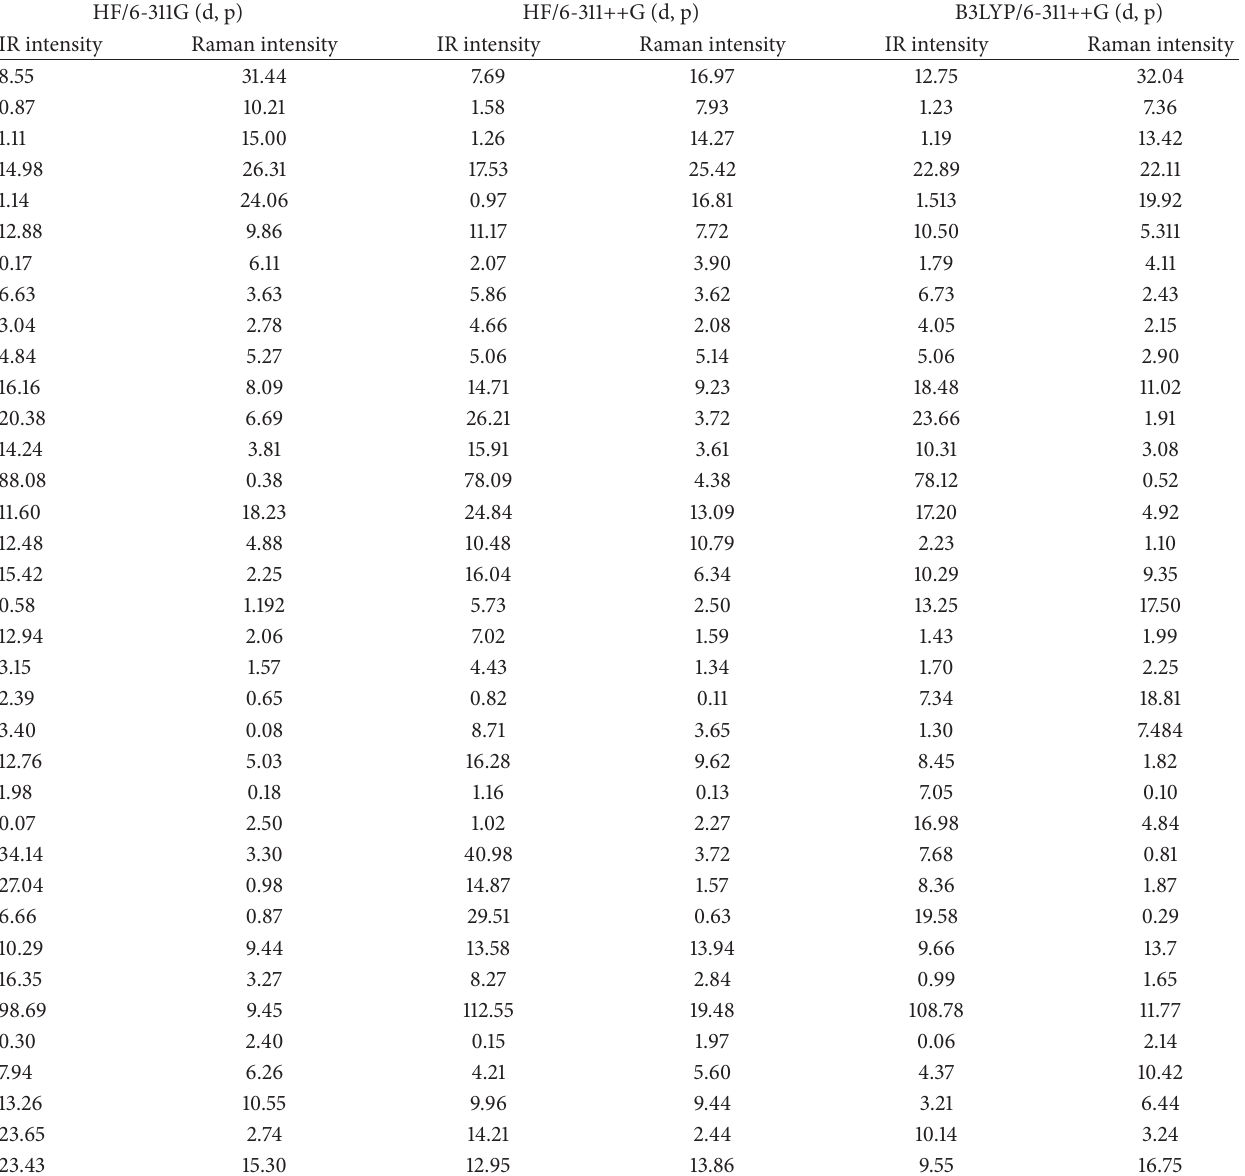
Table 3: Comparative values of IR and Raman intensities between HF/6-311G++(d, p) and B3LYP/6-311G++(d, p) of